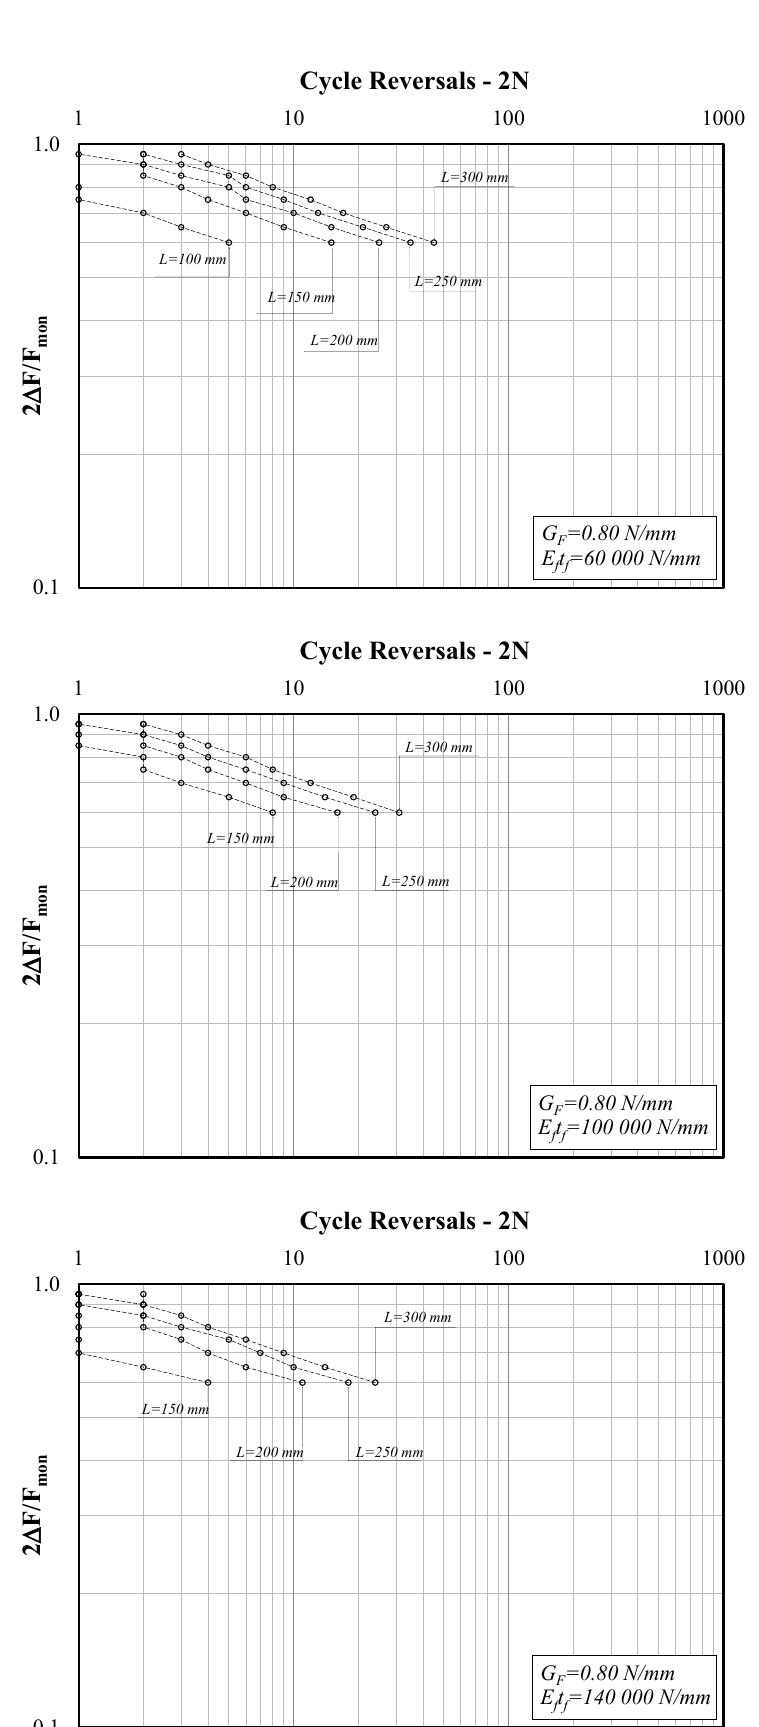
Figure 6. Force amplitude ratio (2 Δ F/F mon ) vs. cycle reversals at debonding (G F = 0.80 N/mm).